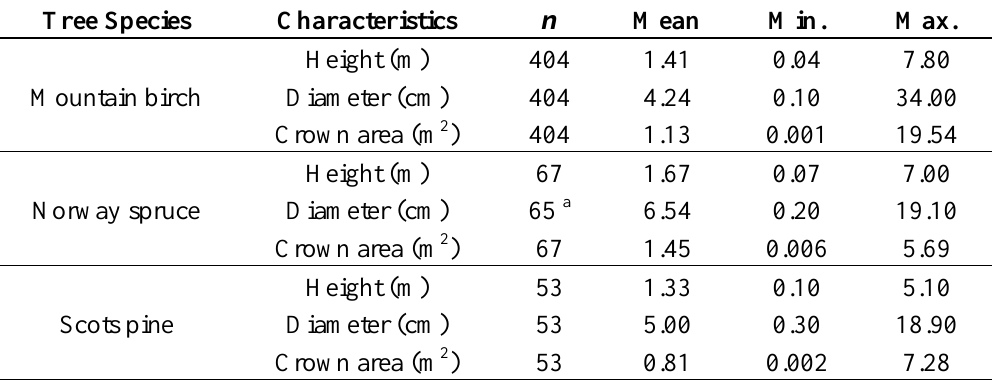
Table 1. Summary of field measurements of